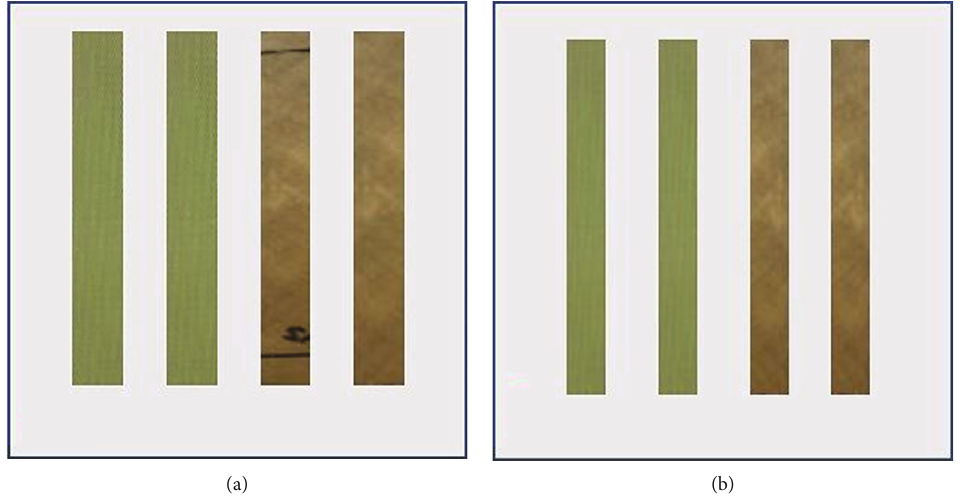
Figure 4: Photographic images of (a) tensile and (b) fl exural